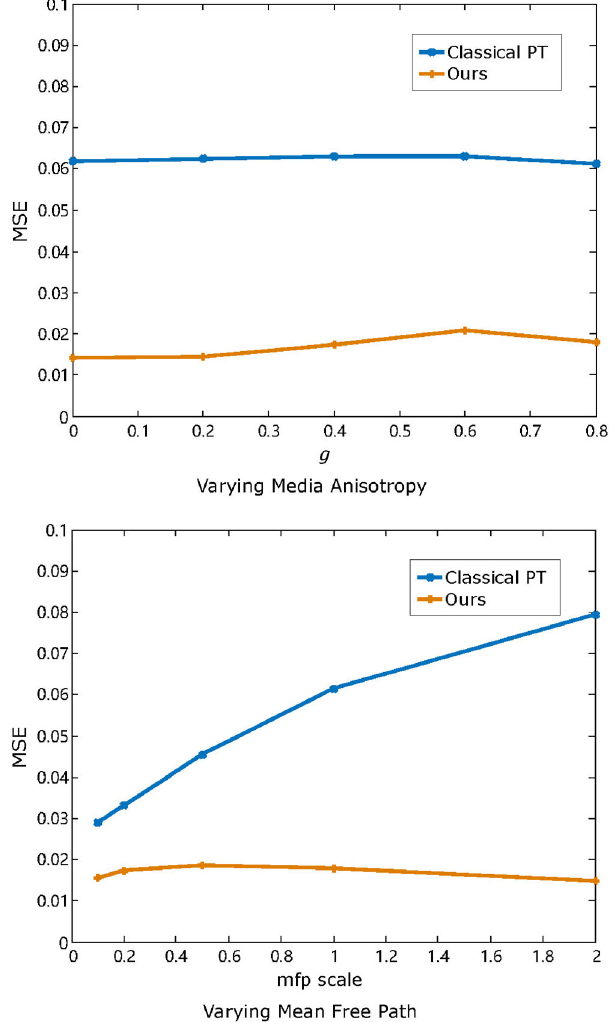
Fig. 21 Error (MSE) for our method and path tracing with equal time (about 20 minutes), as a function of media anisotropy and the media mean free path, for the Candle